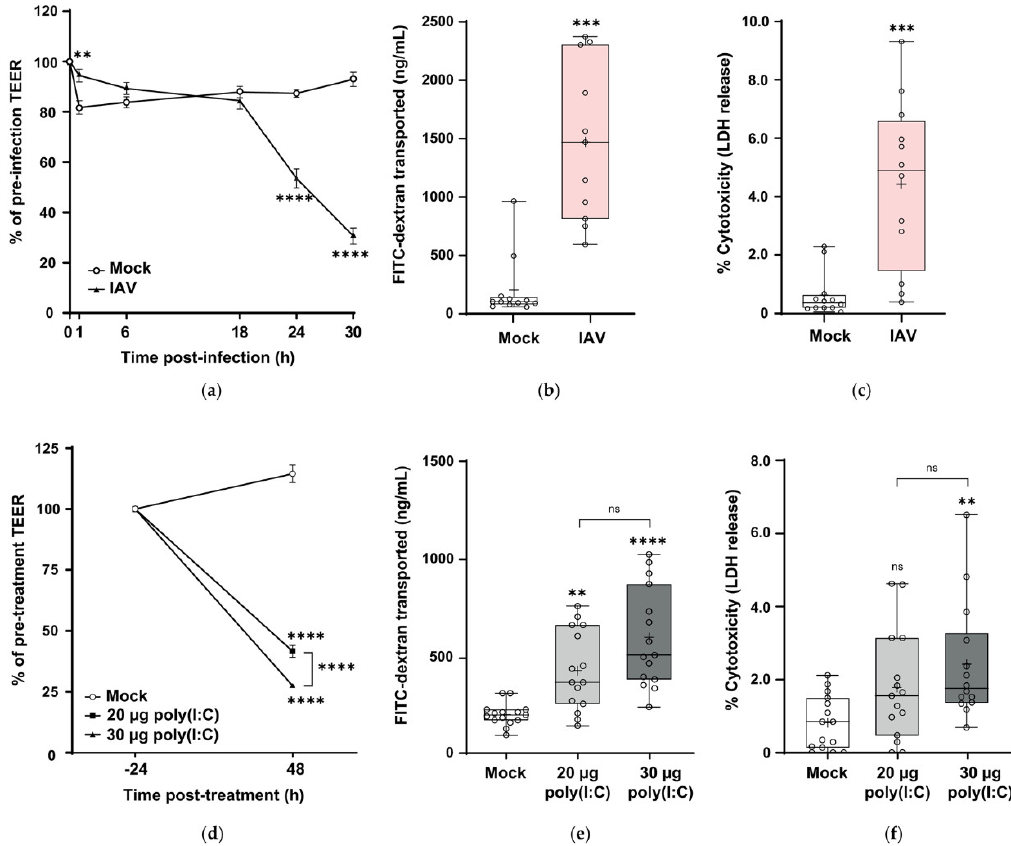
Figure 3. Influenza A/H1N1pdm09 and poly(I:C) damage the in vitro airway epithelium. ( a - c ) wdNHBE cells were inoculated with H1N1pdm09 (MO1 1) and barrier integrity compared to mock-inoculated cells. ( a ) Percentage change in transepithelial electrical resistance (TEER) readings at selected timepoints over a 30 h period postinfection for mock and H1N1pdm09-innoculated cells. ( b ) Paracellular transport of FITC-dextran (4 kDa, ng/mL) and ( c ) LDH release (percentage cytotoxicity) at 30 h postinfection for mock and H1N1pdm09-infected cells. ( d-f ) wdNHBE cells treated with 20 µg or 30 µg poly(I:C) were assayed 48 h post-treatment and compared to mock-treated cells for ( d ) percentage change in TEER, ( e ) FITC-dextran transported (ng/mL) and ( f ) LDH release. Data from three independent experiments for each of the H1N1pdm09 and poly(I:C) challenges were pooled and analyzed as described (Methods). For IAV TEER analyses, n = 36 biological replicates for each of the IAV and mock treatments per timepoint were used, apart from the 30 h mock treatment, n = 35. For IAV FITC-dextran and percentage cytotoxicity, n = 12 per treatment were analyzed. For Poly(I:C) TEERs, mock, n = 45; 20 µg, n = 30; 30 µg, n = 45 per group. For poly(I:C), FITC-dextran transported and cell cytotoxicity n = 15 per treatments were used, with the exception of the percentage cytotoxicity for 30 µg poly(I:C), n = 14. ( a ) and ( d ) are presented as mean ± SEM. ( b ), ( c ), ( e ) and ( f ) are presented as box and whisker plots which show the mean (+), median, interquartile range and maximum and minimum values. The ends of each box represent the upper and lower quartiles, the horizontal line within the box indicates the median value and error bars show the minimum and maximum values. Individual values are depicted by open circles. Statistical significance is indicated: ns, not significant; **, p < 0.01; ***, p < 0.001; ****, p < 0.0001.